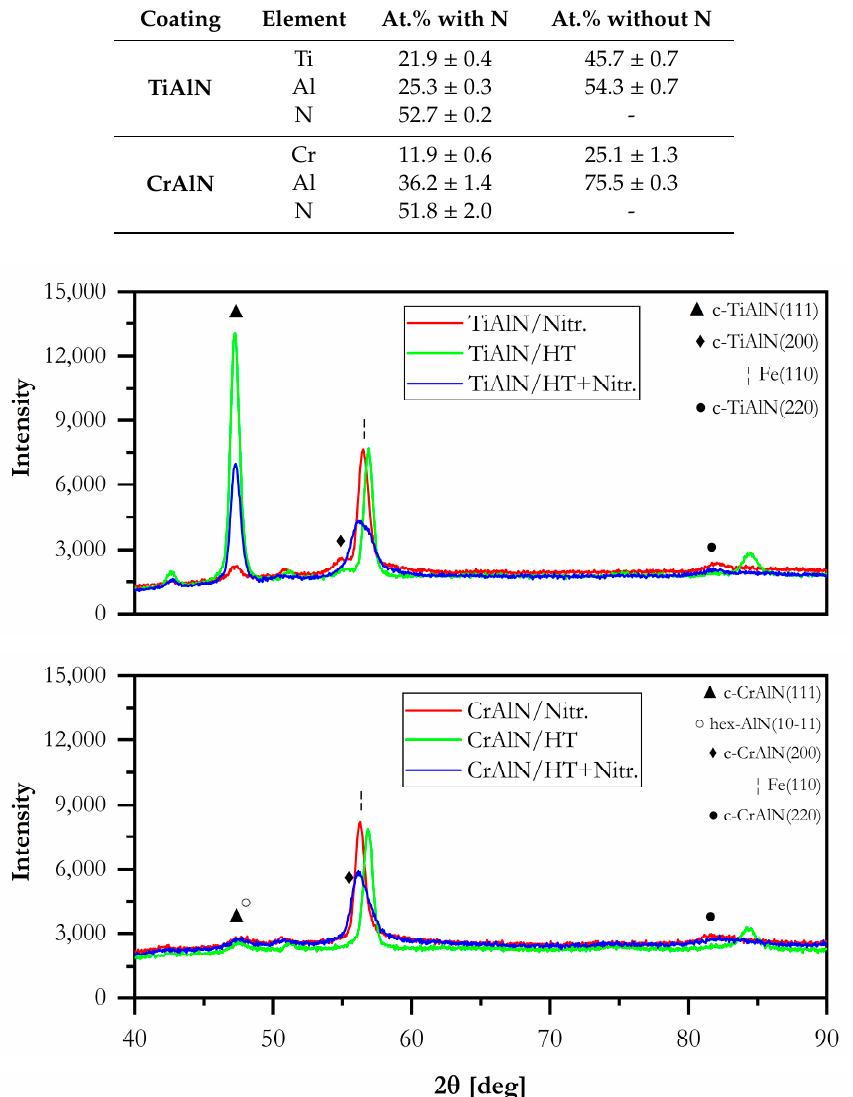
Table 1. The chemical composition of the TiAlN and CrAlN monolayers as measured by EDX.